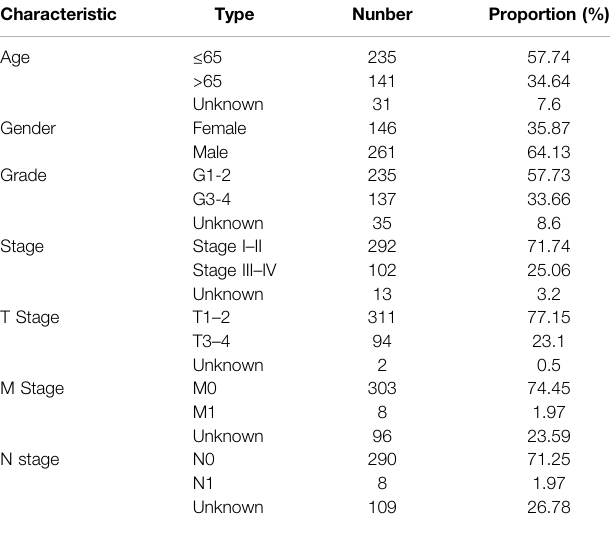
TABLE 1 | Baseline data of all HCC